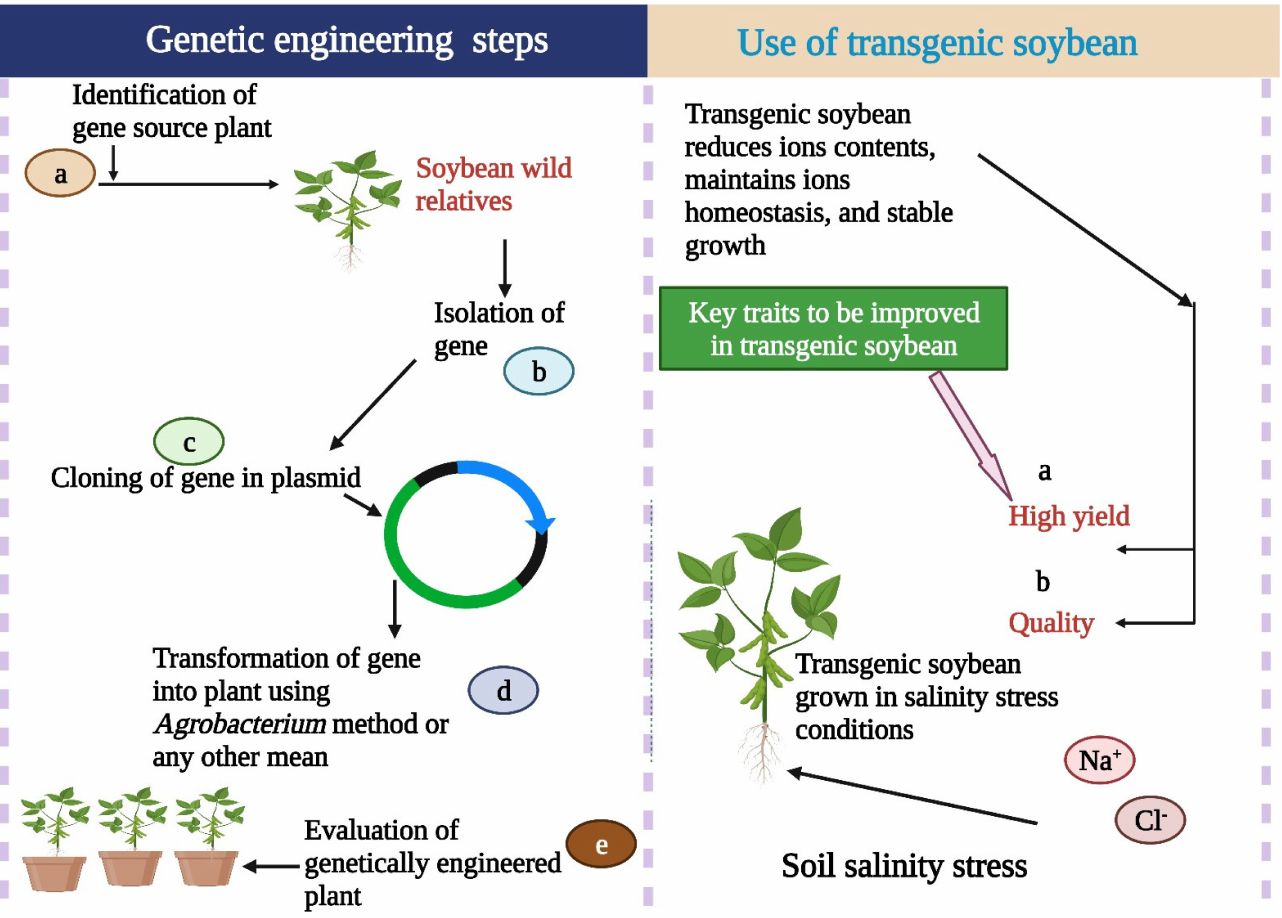
Figure 2. Genetic engineering has a major role in salinity tolerance in soybean. Transgenic soybean cultivars maintain growth and yield under salinity stress conditions. This Figure is created with